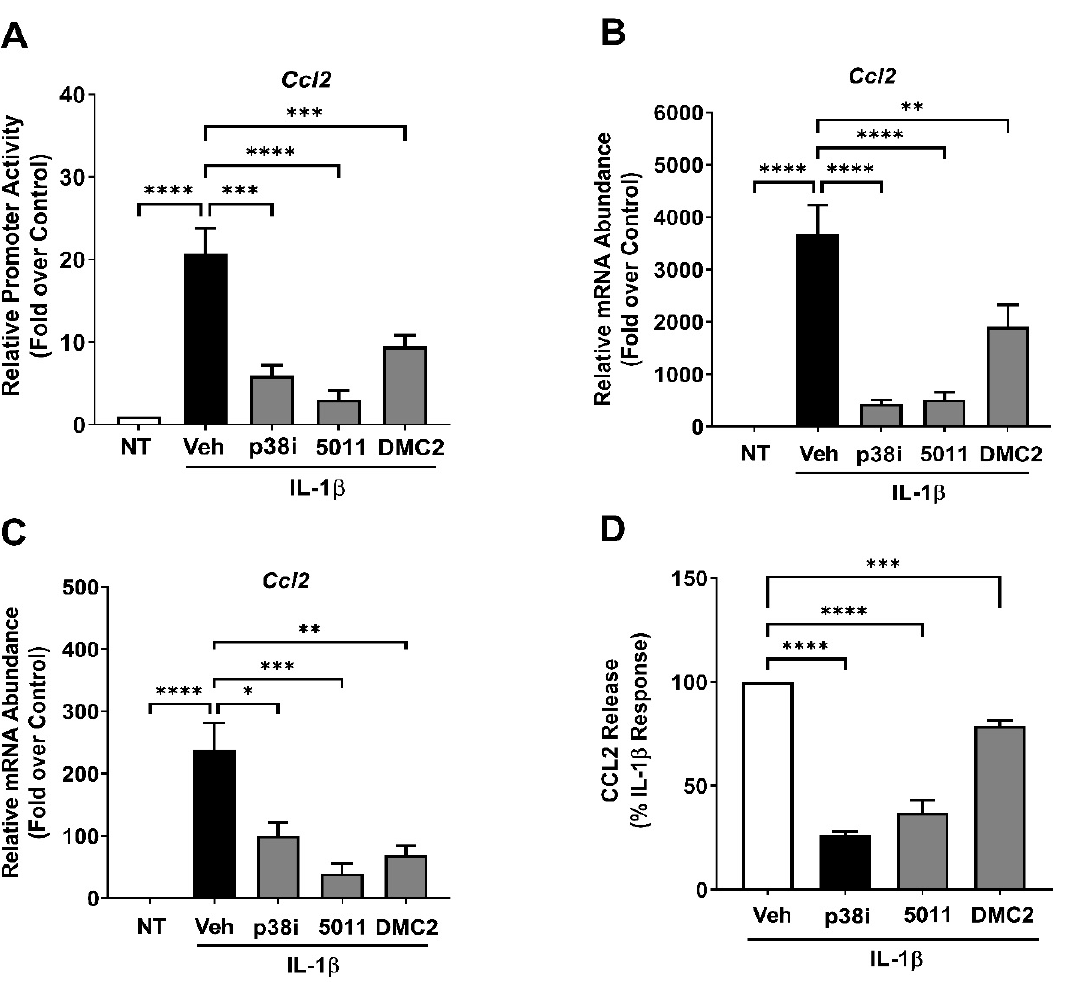
Figure 4. PMI 5011 and DMC2 reduce Ccl2 gene expression and protein secretion. ( A ) 832/13 cells were transfected with a plasmid containing the − 3.6kb Ccl2 promoter driving a luciferase reporter. 24 h after transfected, the cells were treated with 10 μ M of the p38 MAPK inhibitor SB202190 (p38i), 10 μ g/mL PMI5011, or 35 μ M DMC2 for one hour, followed by exposure to 1 ng/mL IL-1 β for 4 h. Luciferase activity is plotted as the fold response over untreated (no IL-1 β ) veh control. ( B ) 832/13 cells were treated with 10 μ M of the p38 MAPK inhibitor SB202190, 10 μ g/mL PMI5011, or 35 μ M DMC2 for one hour, followed by exposure to 1 ng/mL IL-1 β for 3 h. Expression of the Ccl2 transcript was measured by qPCR. ( C ) Isolated mouse islets were treated with 10 μ M p38i, μ g/mL PMI5011, or 35 μ M DMC2 for one hour, followed by exposure to 1 ng/mL IL-1 β for 3 h. Expression of the Ccl2 gene was analyzed by qPCR. ( D ) 832/13 cells were treated with 10 μ M of the p38 MAPK inhibitor SB202190, 10 μ g/mL PMI5011, or 35 μ M DMC2 for one hour, followed by exposure to 1 ng/mL IL-1 β for 6 h. Secretion of Ccl2 into the cultured media was assayed by ELISA. Data shown are expressed as the percentage of the maximal secretion response induced by IL-1 β . *, p < 0.05; **, p < 0.01; ***, p < 0.001; ****, p < 0.0001.